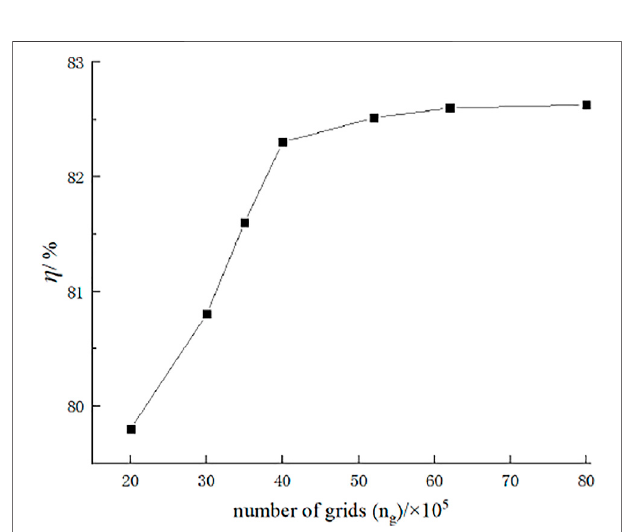
FIGURE 3 | Grid-independent analysis of computational domain of the full-tubular